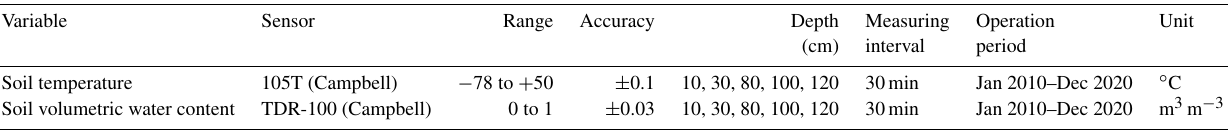
Table 2. List of sensors, accuracy, measuring height and interval, and operation period for soil temperature and soil volumetric water content within the active layer at the Mahan Mountain satiation.